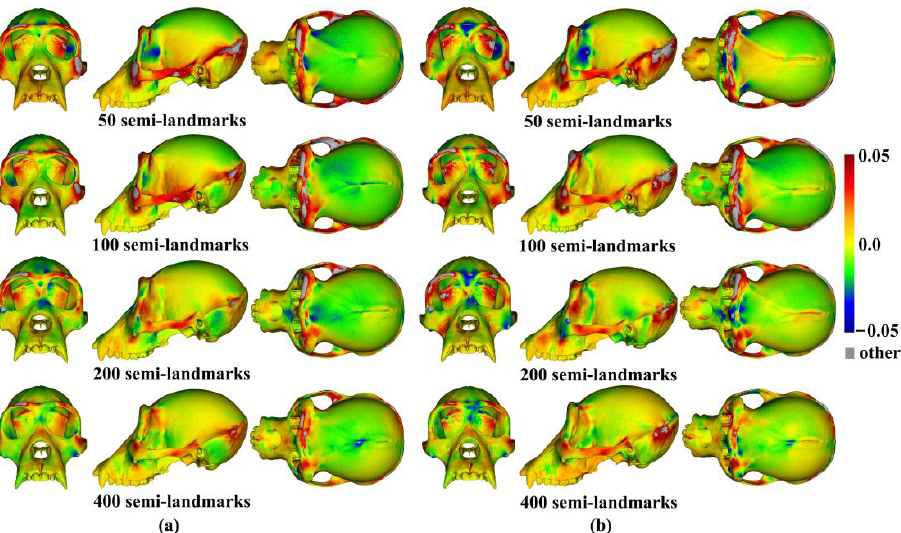
Figure 13. Colour maps of local surface mesh area differences among mean surfaces of ape crania derived using lower densities (target) and 800 semilandmarks (reference) based on different semi- landmarking approaches. ( a ) Sliding TPS. ( b ) TPS&NICP. Scale bar indicates difference in local area between reference and target surfaces expressed as a proportion of the reference area.